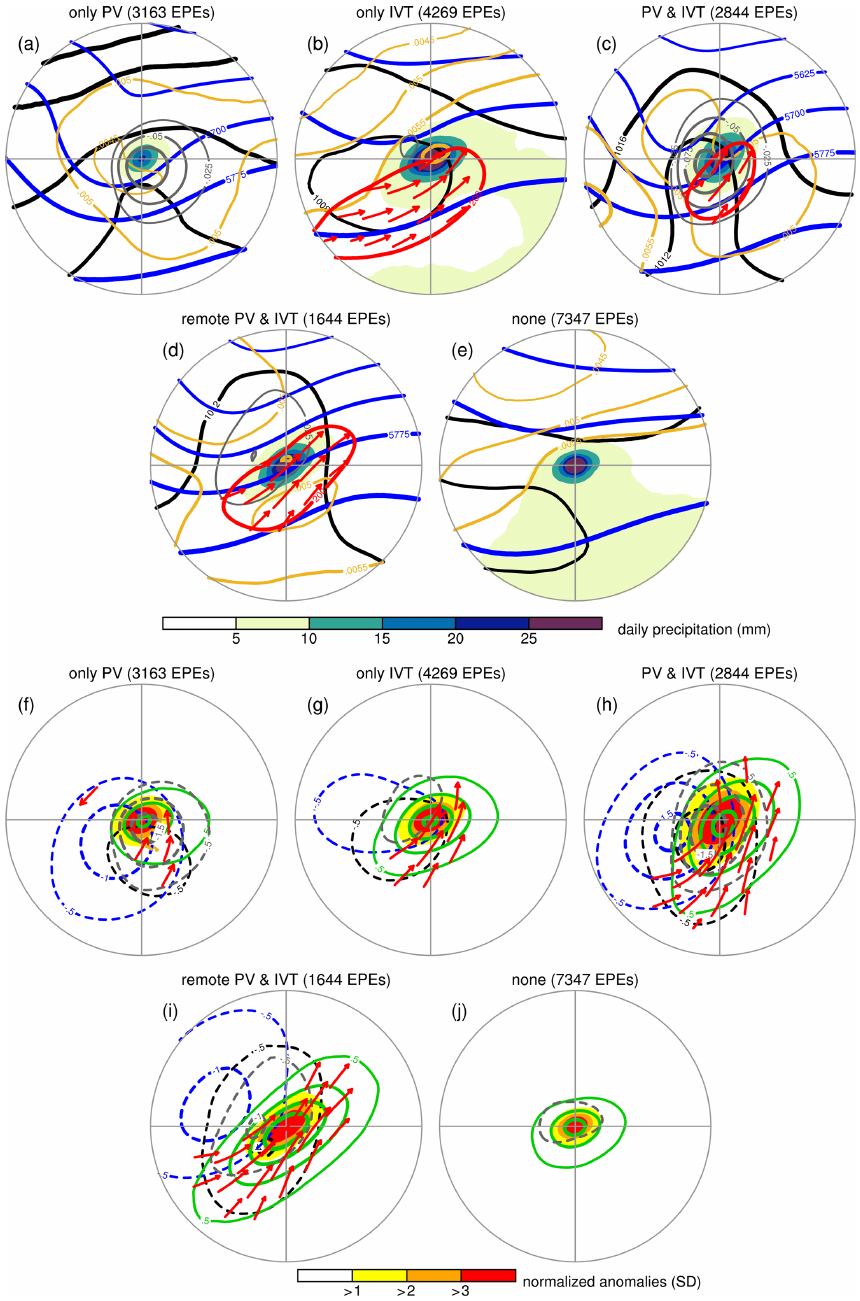
Figure 11. Composites, as in Fig. 10, but for EPEs over subtropical land, for the period of 1979–2016, and for five exclusive categories of EPEs that match (a, f) PV structures only, (b, g) IVT structures only, (c, h) combined PV and IVT structures with a direct PV influence, (d, i) combined PV and IVT structures with a remote PV influence only, and (e, j) neither PV structures nor IVT structures, as detailed in the text and Table 1. The composites also include in (a–e) daily-mean contours of QG vertical motion (Pas − 1 , in grey; only ascent is shown, denoted by negative values) and static stability (K m 2 kg − 1 , in orange), and in (f–j) their normalized anomalies in identical colours, with those of static stability displayed for intervals of − 0 . 25SD starting at − 0 . 25SD. Different from Fig. 10, the IVT contours in (a–e) correspond to